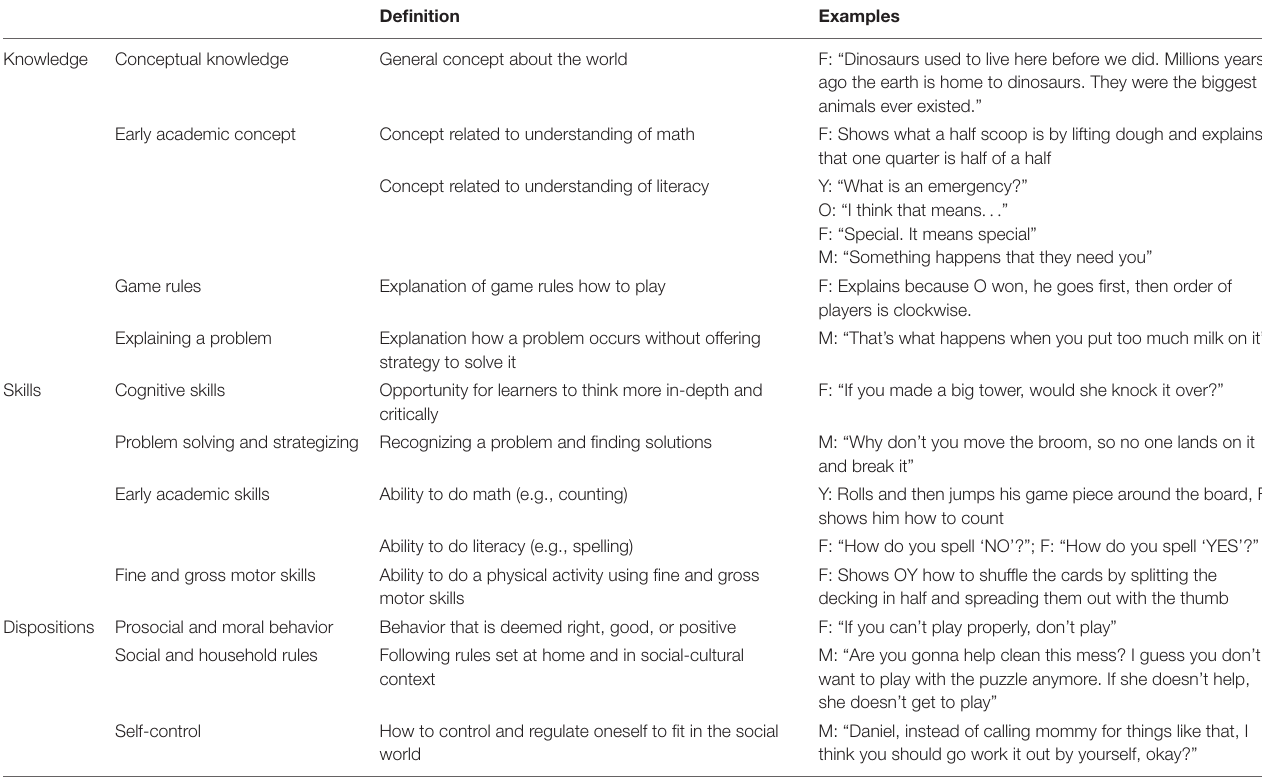
TABLE 3 | Definitions and examples of subcategories of parental teaching for each domain of